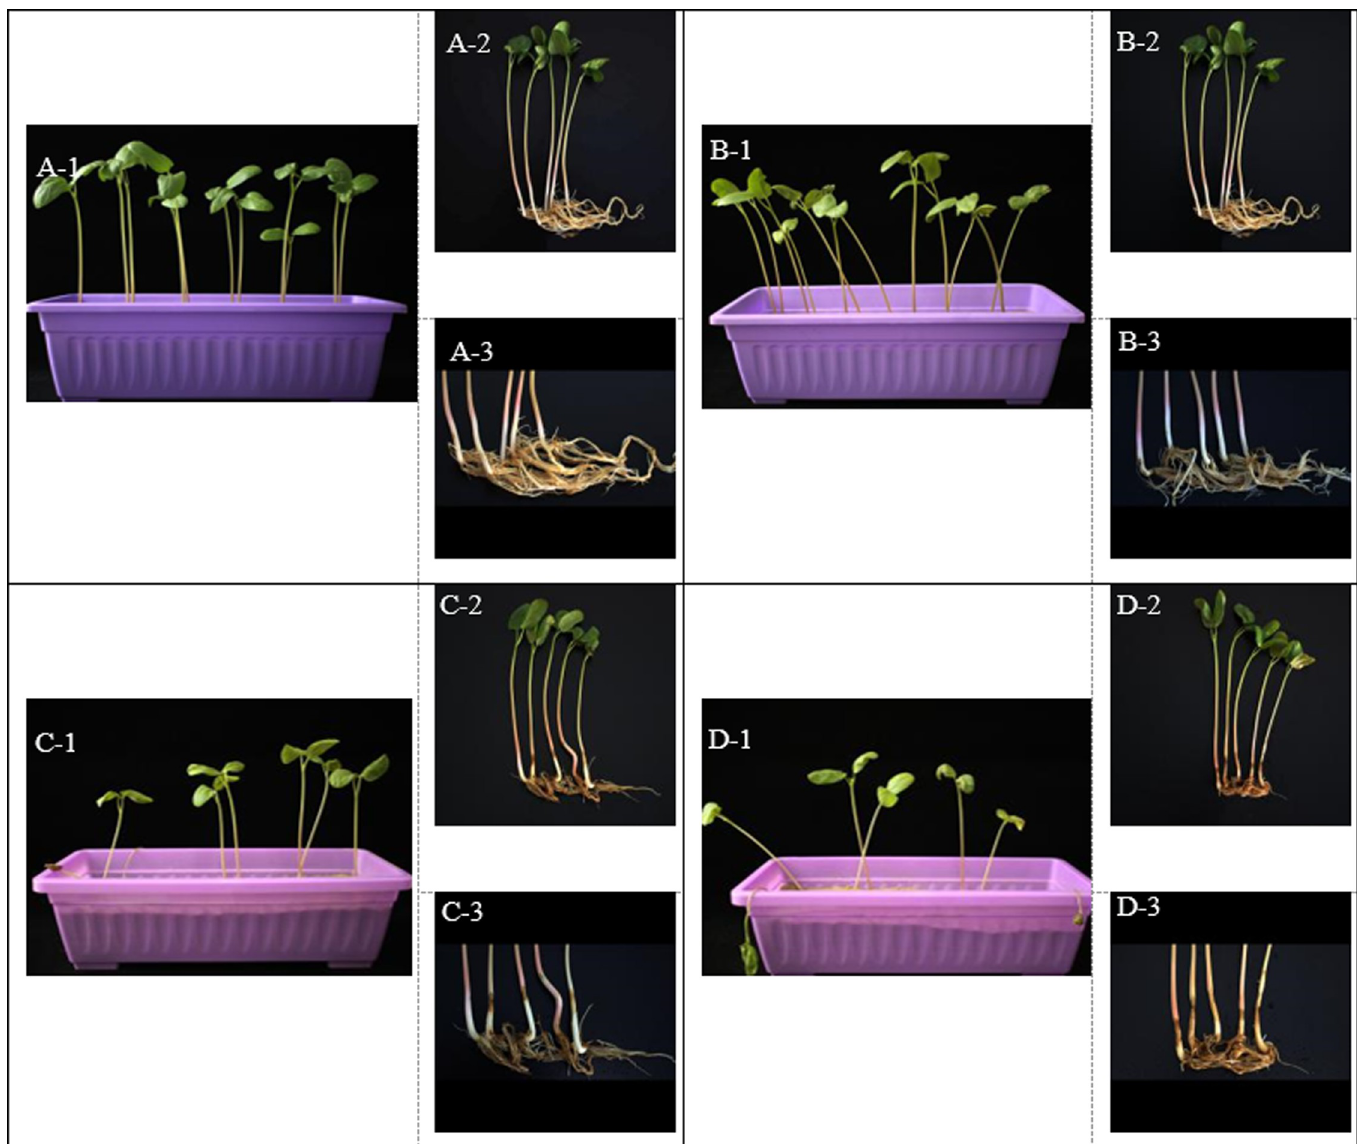
Fig 1. Growth status of castor plant and root system under different doses of Cd stress. Note: A1-A3: Intact plants and their roots under no Cd treatment; B1-B3: Intact plants and their roots under 300 mg/L Cd treatment; C1-C3: Intact plants and their roots under 700 mg/L Cd treatment Roots; D1-D3: Intact plants and roots under 1000